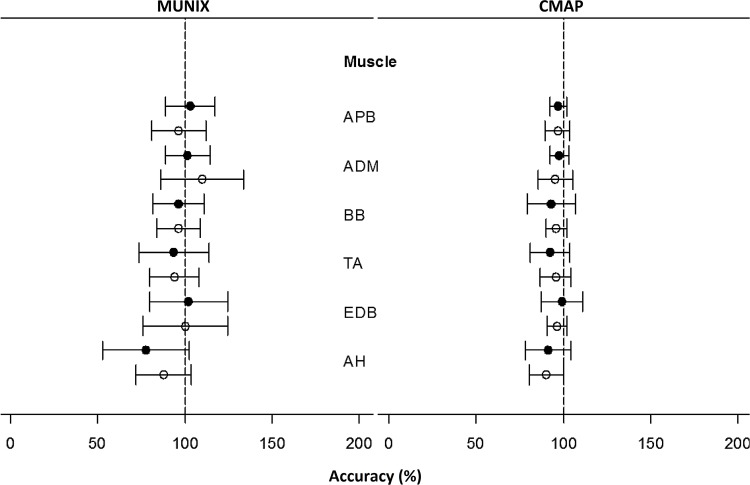
Relative mean and standard deviation of MUNIX and CMAP measurements in individual muscles of the experienced group (filled circles) and less-experienced group (empty circles) compared to the hypothetical reference values, expressed as accuracy (%).